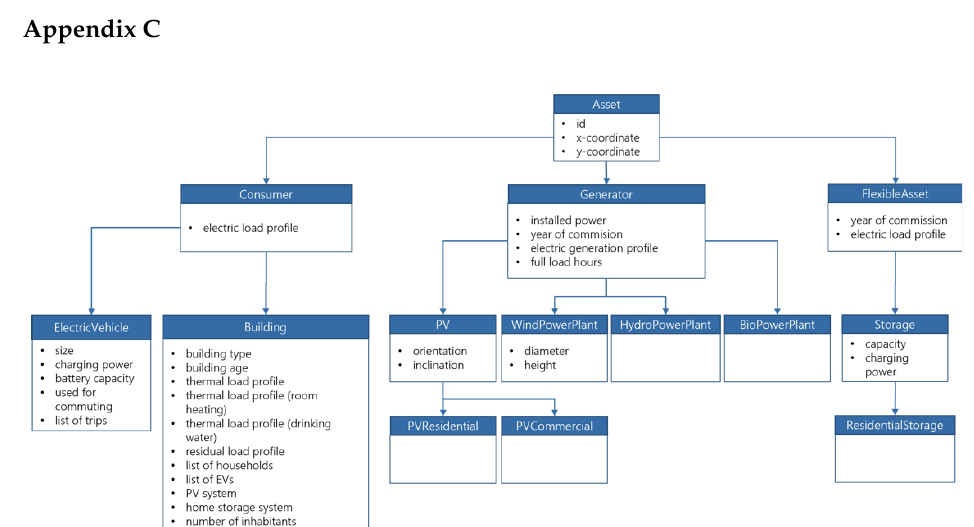
Figure A2. Simplified visualization of the hierarchy and attributes of classes used for generating a digital representation of the assets inside a municipality using the preprocessing module of the simulation framework. Each class inherits all attributes of its parent class.